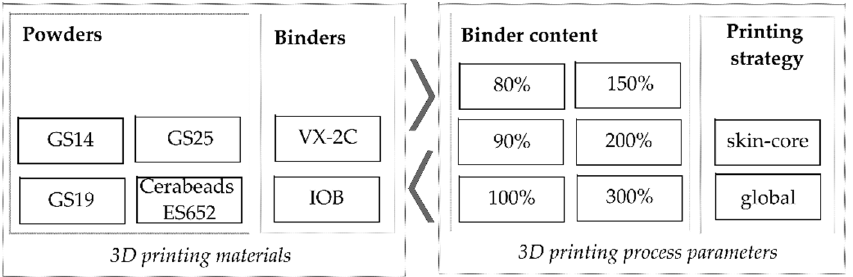
Figure 12. Planned variations regarding 3D printing of sand tools.